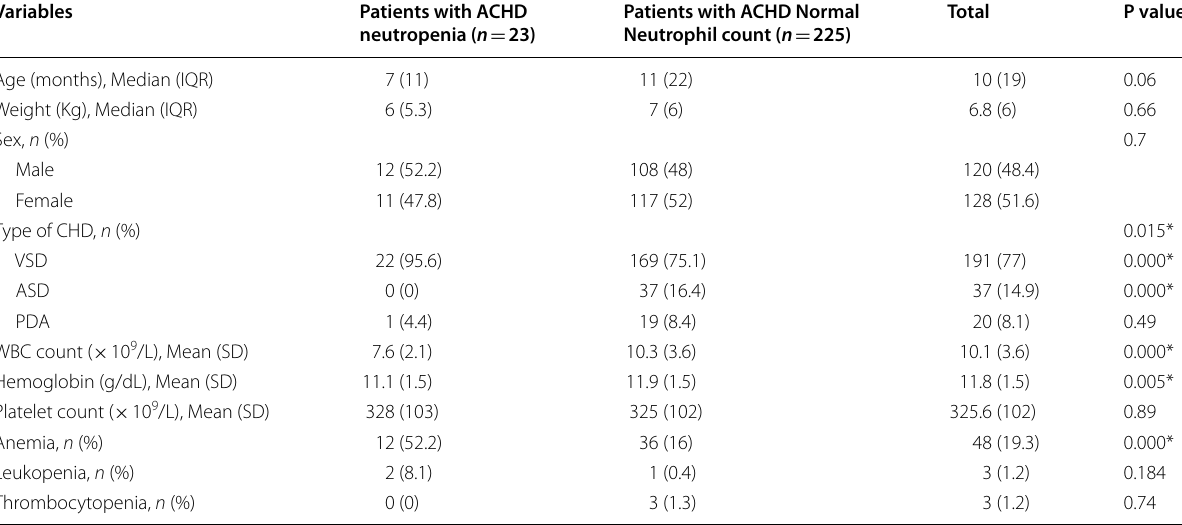
Table 1 Clinical data and Hematological profile of ACHD patients with neutropenia compared with a normal Neutrophil count